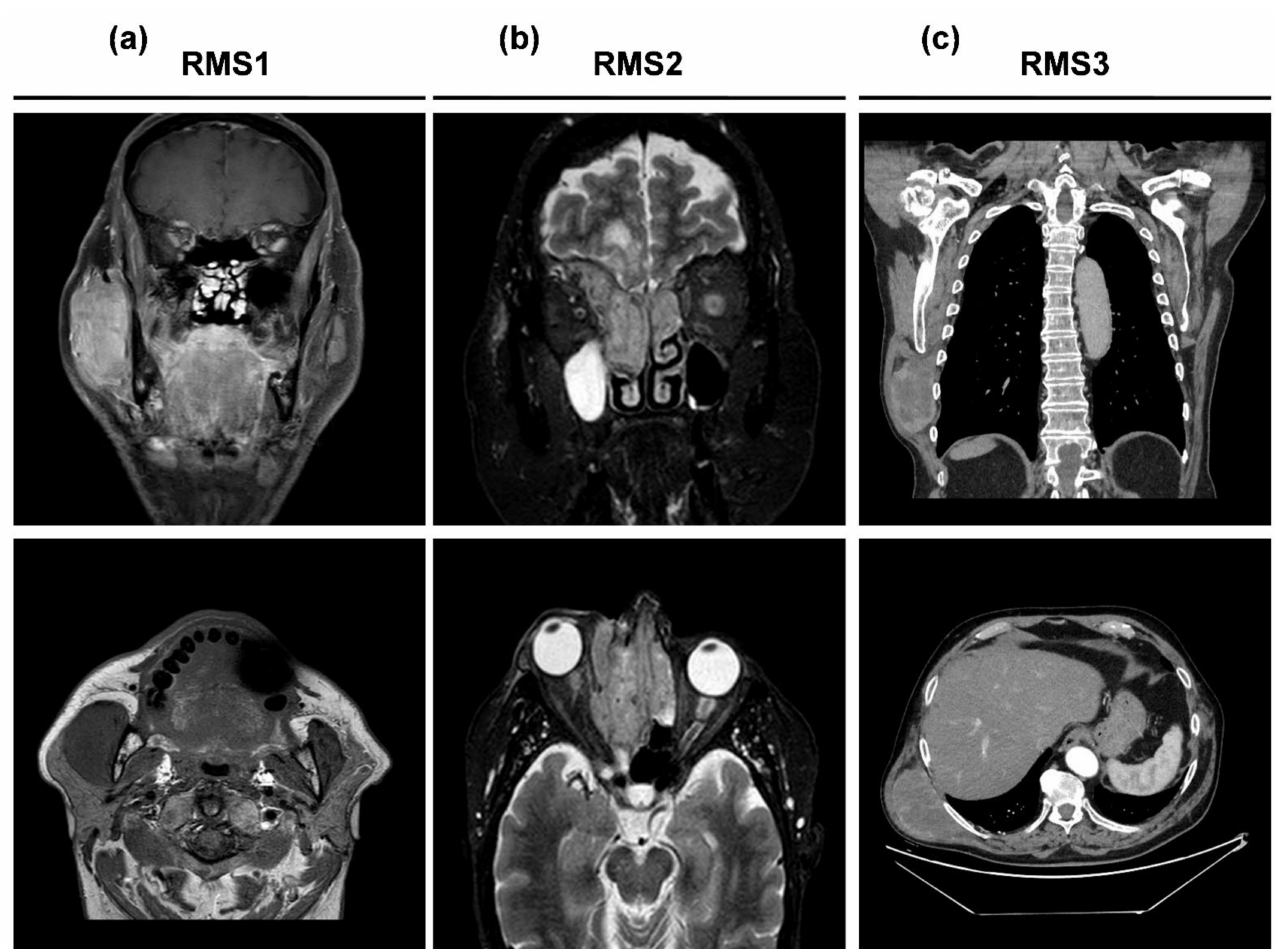
Figure 1. ( a ) Coronal and axial post-contrast MRI showing an heteroplastic expansive lesion involving a large part of the right masseter muscle measuring 33 mm × 36 mm (axial plane) and extension in the cranio-caudal direction of about 60 mm; ( b ) Coronal and axial post-contrast MRI showing an expansive ethmoidal formation, which also involves the cells of the ethmoidal labyrinth contralaterally. The lesion extends caudally to the right upper and middle nasal cavity, incorporating and displacing the middle turbinate inferiorly and cranially with invasion of the cribrosa lamina and the frontal plane, and in the right frontal-basal intracranial site, with an extension of about 8 mm. The tissue also infiltrates and invades the right orbital cavity in the supero-medial area with an extension of about 13 mm and a compressive-distorting effect on the eyeball, which appears to be displaced inferiorly laterally to the right and on the extrinsic musculature of the eye; ( c ) Coronal and axial post-contrast CT scan expansive lesion along the right posterior axillary line, below the great dorsal muscle, with axial diameters of 9 cm × 5 cm and cranio-caudal extension of approximately 9